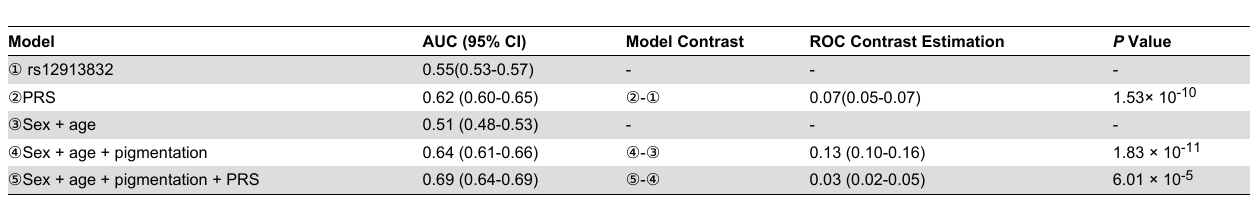
Table 4. Risk prediction performance for different sets of predictors in the MD Anderson data set.